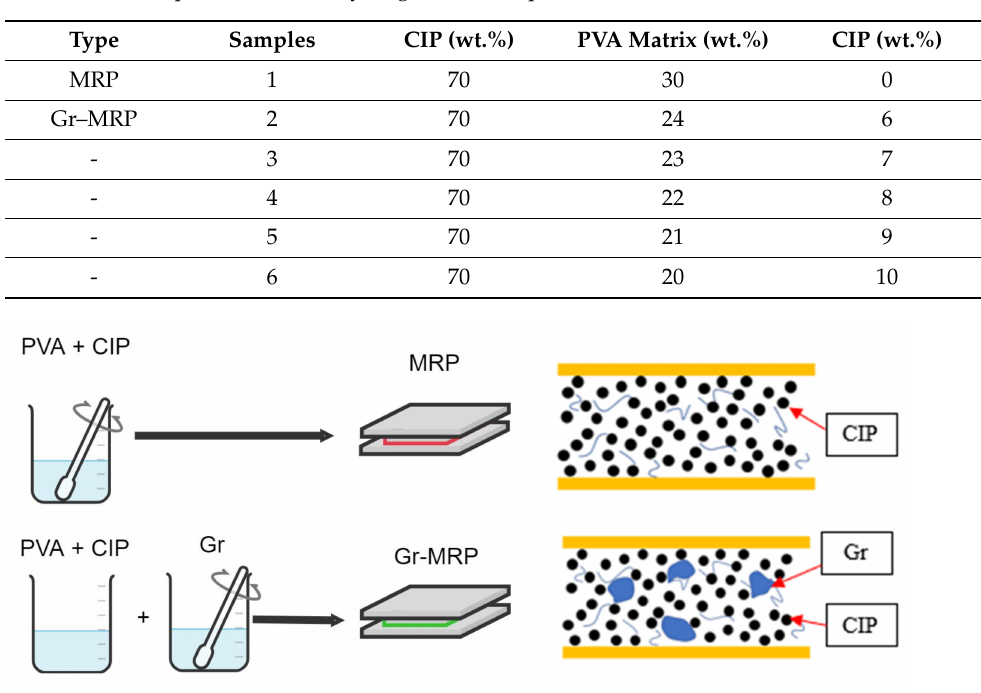
Table 1. The composition of each hydrogel MRP sample.